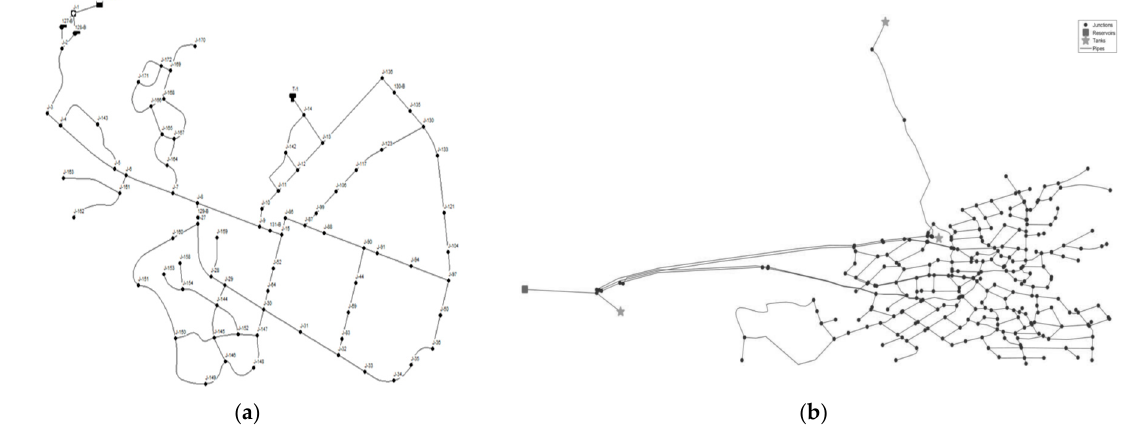
Figure 1. ( a ) The demo network Net22; ( b ) the Aiani